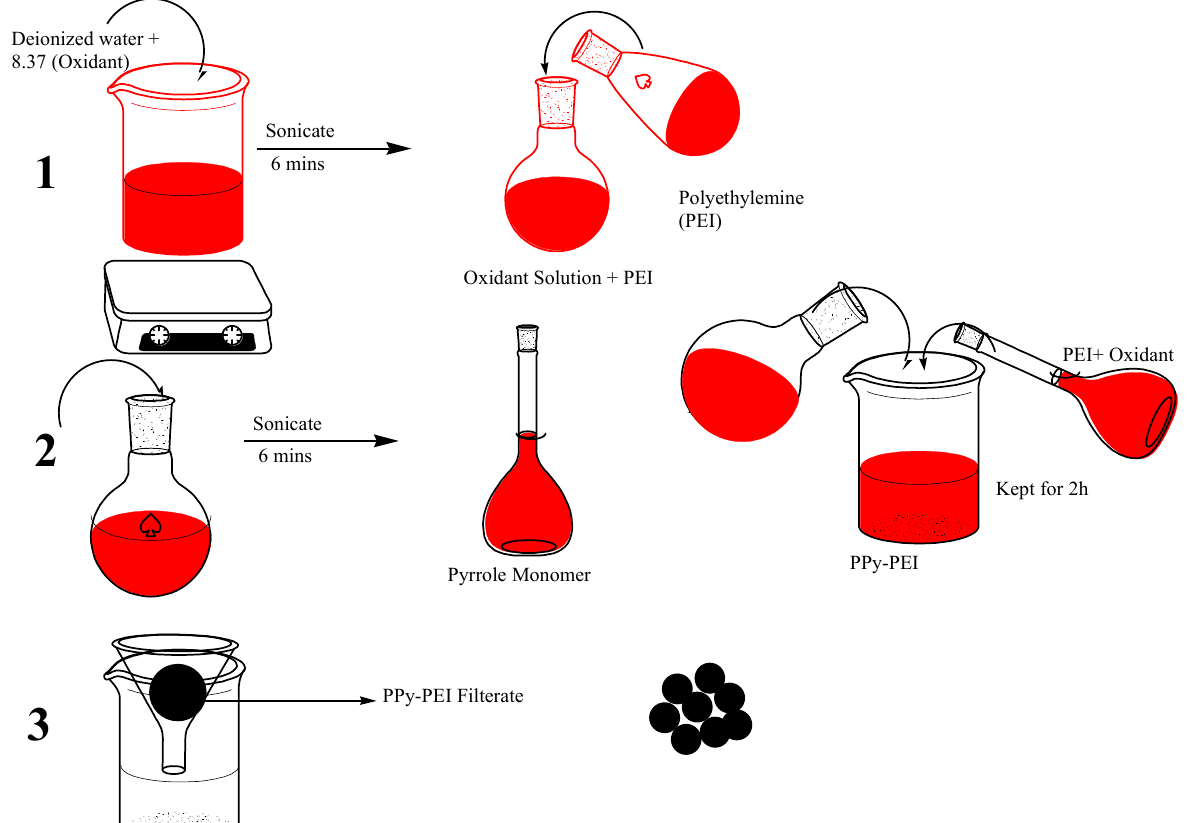
Figure 2. Nanoadsorbent made of polypyrrole and polyethleneimine: Synthesis scheme.